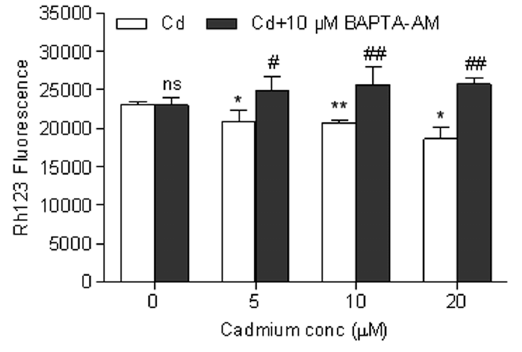
Figure 6. Cd-induced dissipation of Dy m was inhibited by BAPTA-AM. Cells were pretreated with BAPTA-AM (10 m M) for 30 min, followed by treatment with Cd for another 12 h. The Dy m was analyzed by Rh123 staining using flow cytometry. Results were expressed as mean fluorescence. Each bar represents mean 6 SD (n=6). *Statistical significance between control and Cd treatment (5, 10 and 20 m M); # Statistical significance between cells cultured in the absence and presence of BAPTA-AM. ns Not significant; * P , 0.05, ** P , 0.01; # P , 0.05, ## P , 0.01 using Student’s t-test.